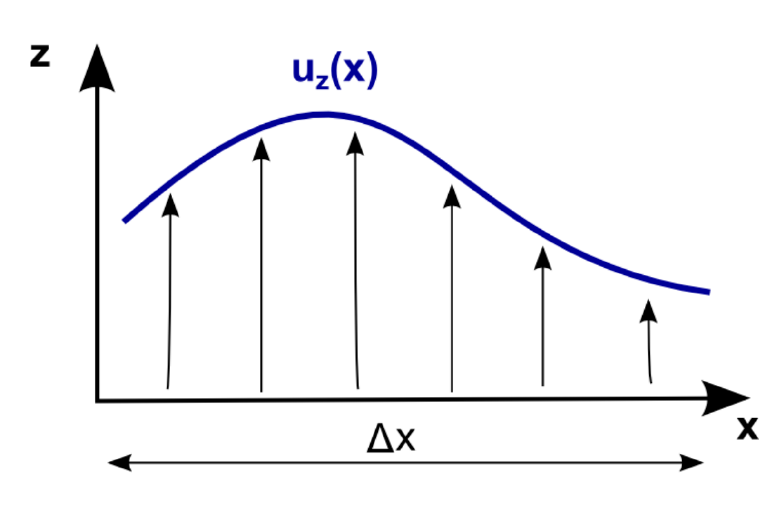
Figure 4. Schematic illustration of a simple two-dimensional velocity shear profile, in which a flow, directed along the z -axis, is characterized by a velocity whose magnitude smoothly varies with the x -coordinate. ∆ x denotes the shear